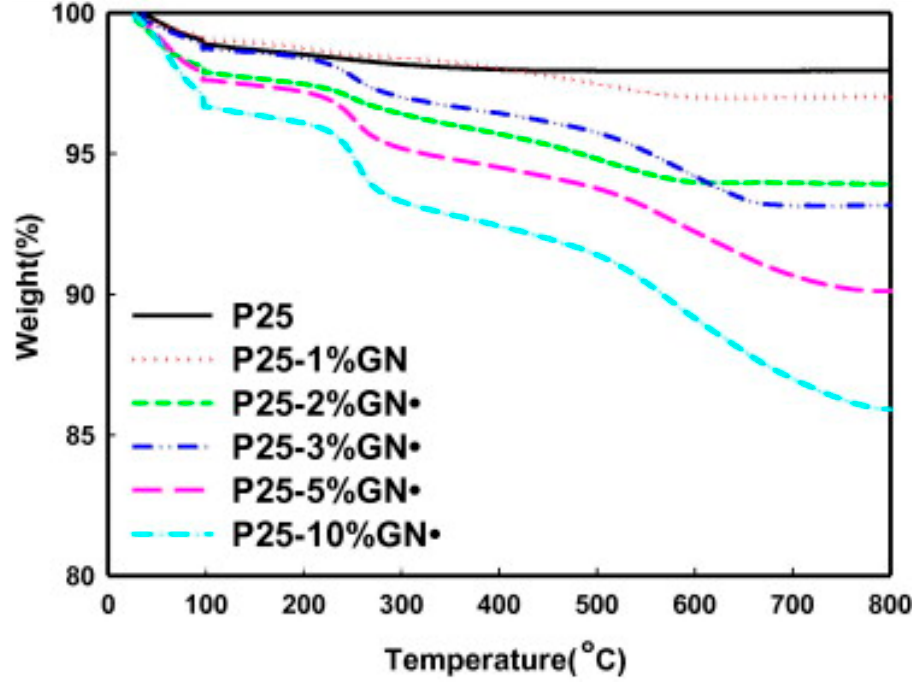
Figure 25. TGA curves for TiO 2 (P25) and TiO 2 /G nanocomposites with different amounts of G. Reprinted with permission from reference [94]. Copyright 2013 Elsevier.